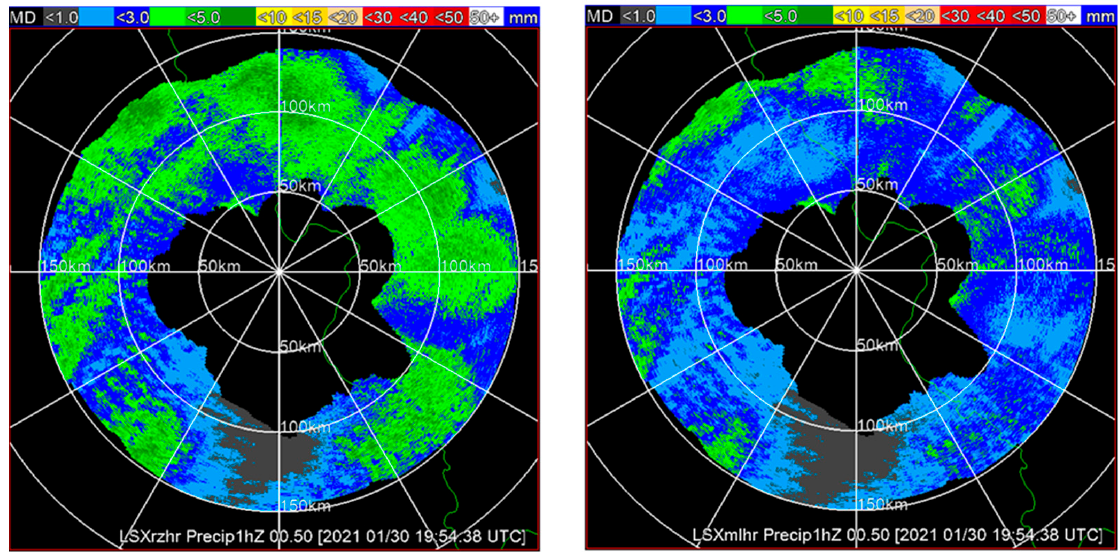
Figure 13. Maps of hourly rain total retrieved from R ( Z ) in the area affected by ML before and after PVPR correction of Z measured by the KLSX WSR-88D radar during the period from 18 to 19 UTC on 30 January 2021.